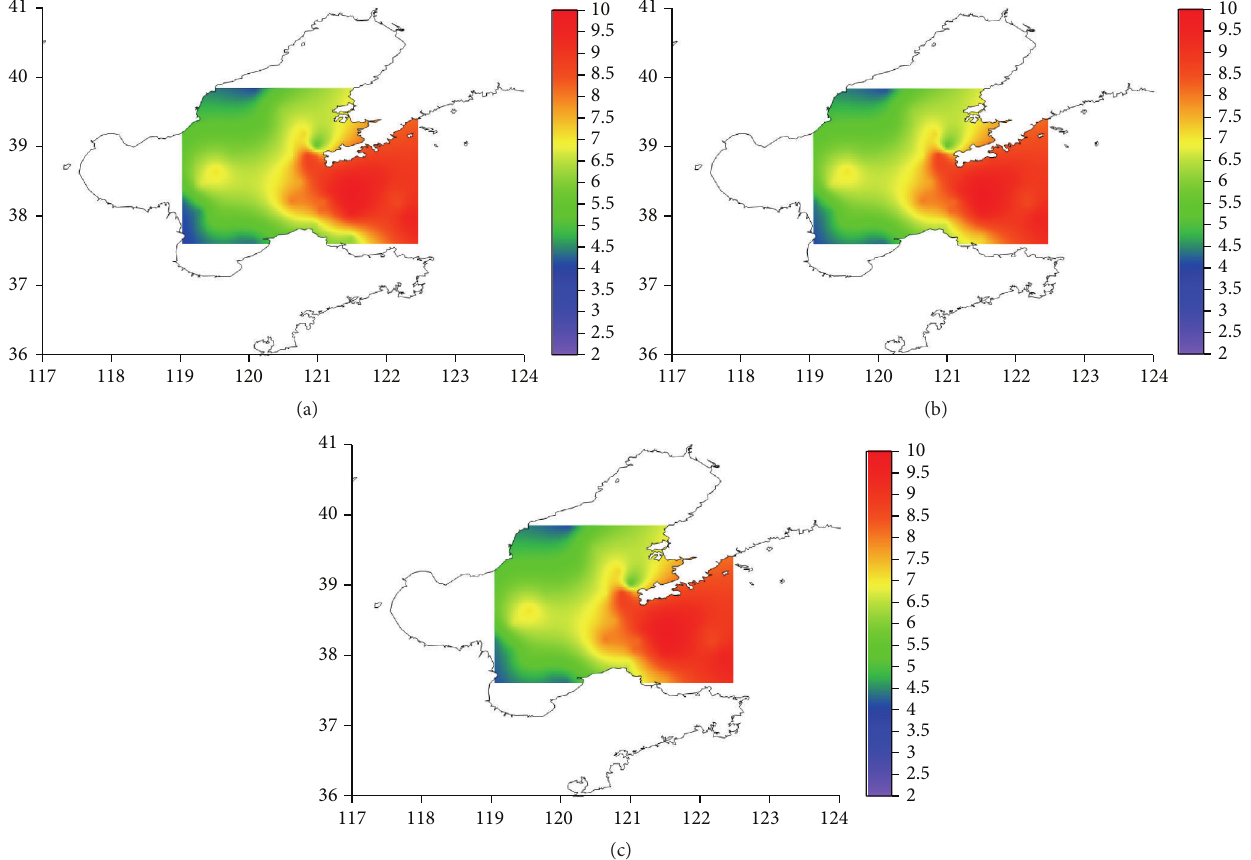
Figure 6: The SST data from 42 cross section stations in Y-B on December 17–24, 2013: (a) sea surface; (b) 10m; (c) sea bottom (unit: ∘